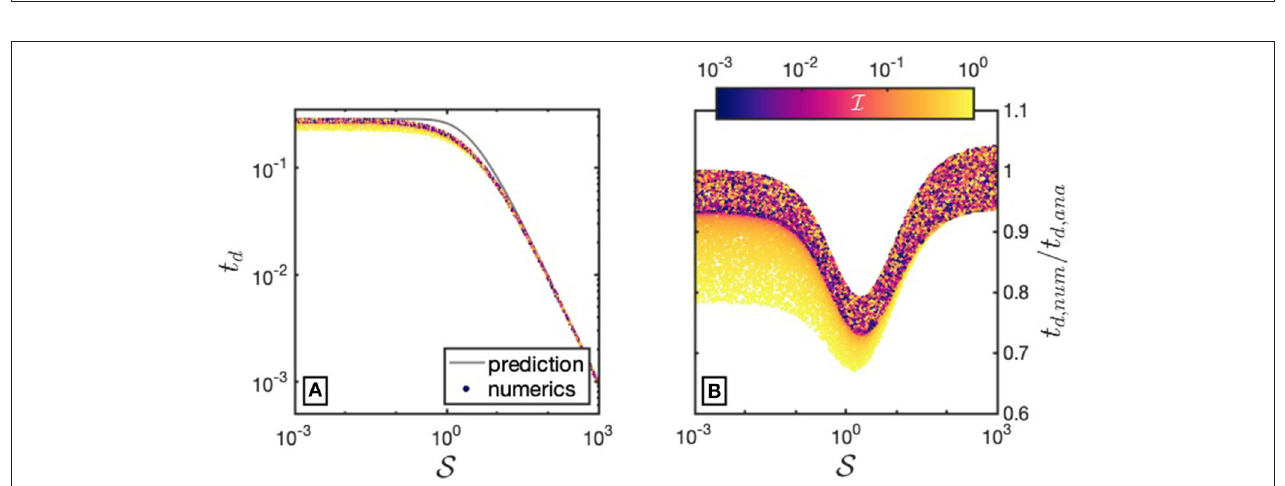
FIGURE 5 | Detachment times t d for a set of 2 10 5 simulations with different input parameters (see text for details). (A) t d as a function of the grain damage × parameter I and thermal damage parameter S . (B) t d as a function of I and